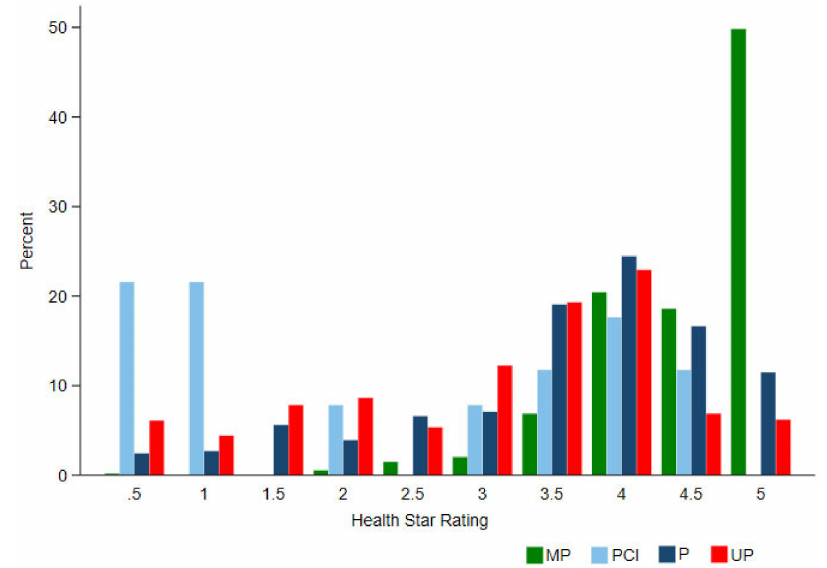
Figure 2. Percent HSR frequency within NOVA categories compared for the total